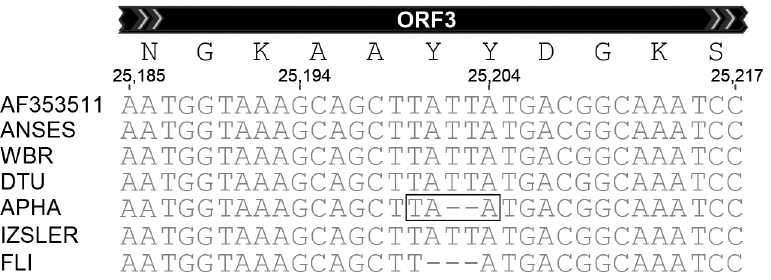
Fig 3. Short, internal, deletions within the ORF3 coding region. A 2 nt deletion within the ORF3 coding region of the APHA strain produces a new termination codon (TAA, boxed) and hence the ORF3 protein is predicted to be severely truncated (see text). A 3 nt deletion in the FLI sequence should result in the loss of a single amino acid but since the initiation codon of ORF3 is lost in this virus (see Fig 2) then this change is unlikely to have any